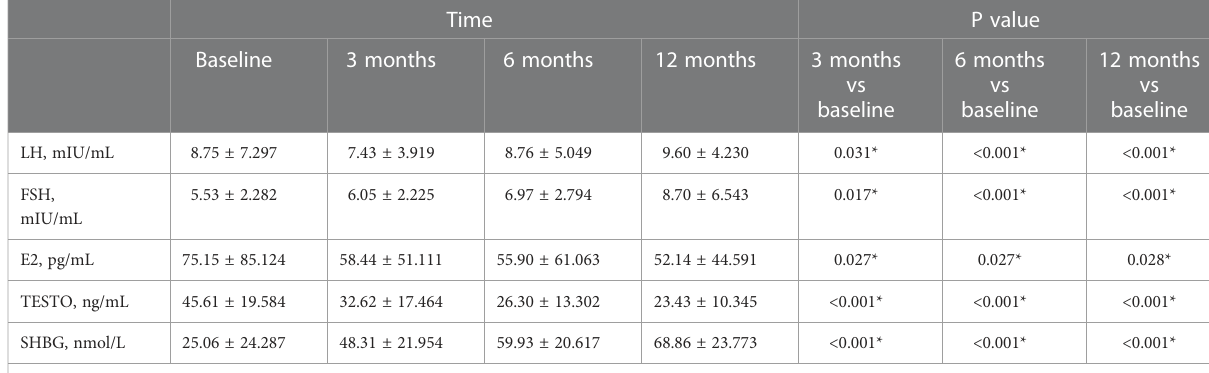
TABLE 3 Comparison of preoperative and postoperative sex hormone levels at 3, 6 and 12 months a .